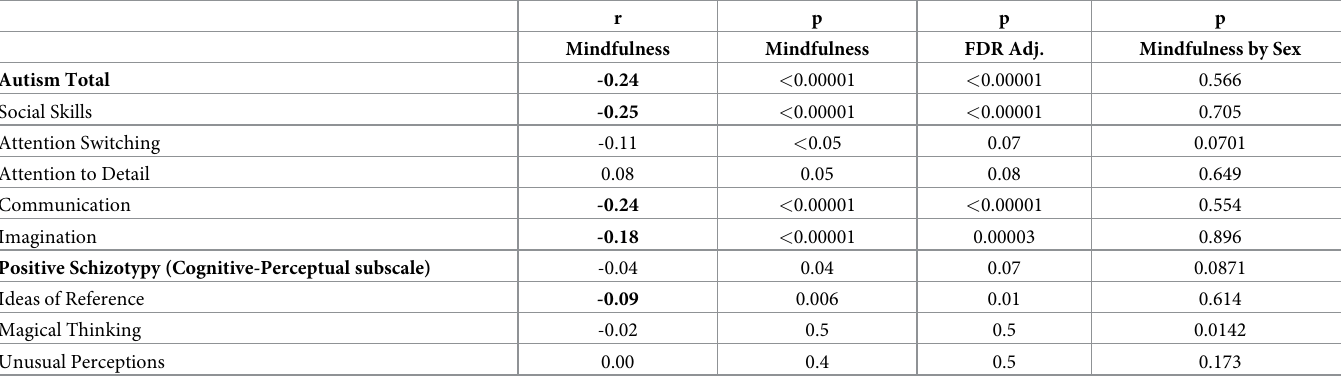
Table 5. Correlations of mindfulness with autism and schizotypal traits, and results from ANCOVAs testing for sex by trait interaction effects.